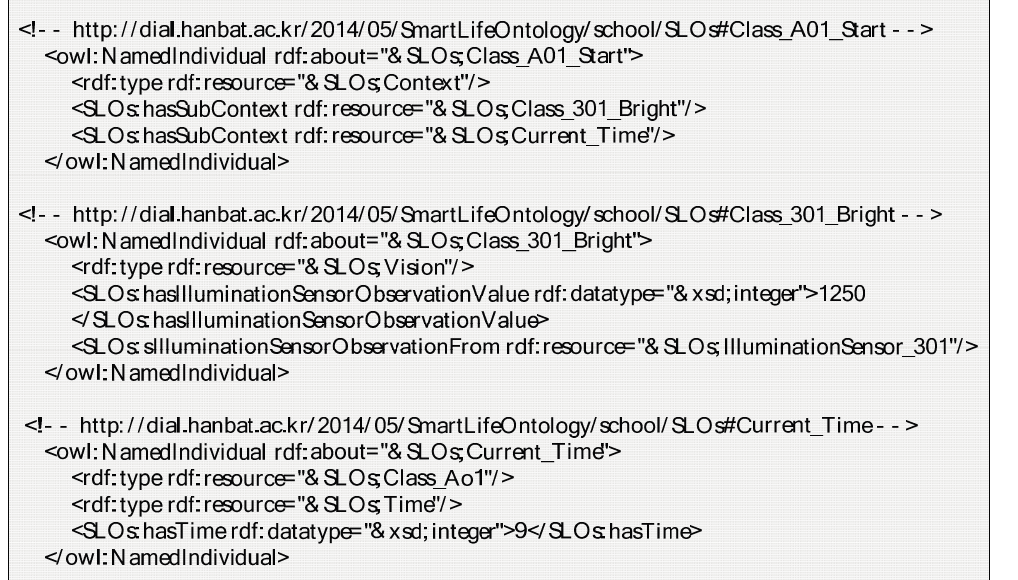
Figure 22. OWL description of Class_A01_Start with its sub-contexts.